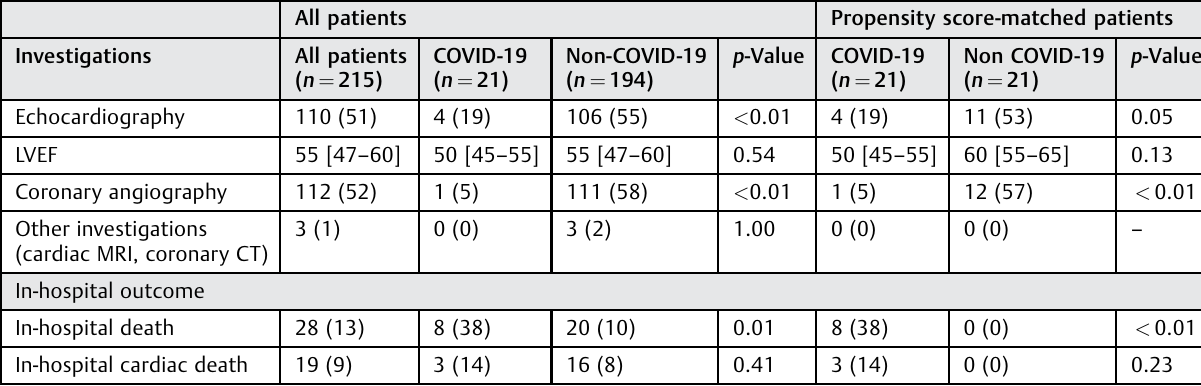
Table 2 In-hospital outcomes All patients Propensity score-matched